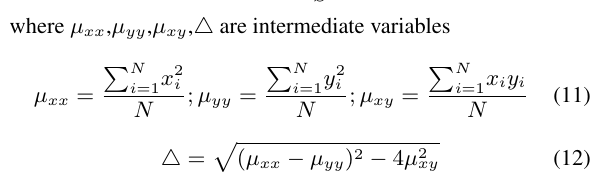
Figure 10: Interferences of lane boundary.